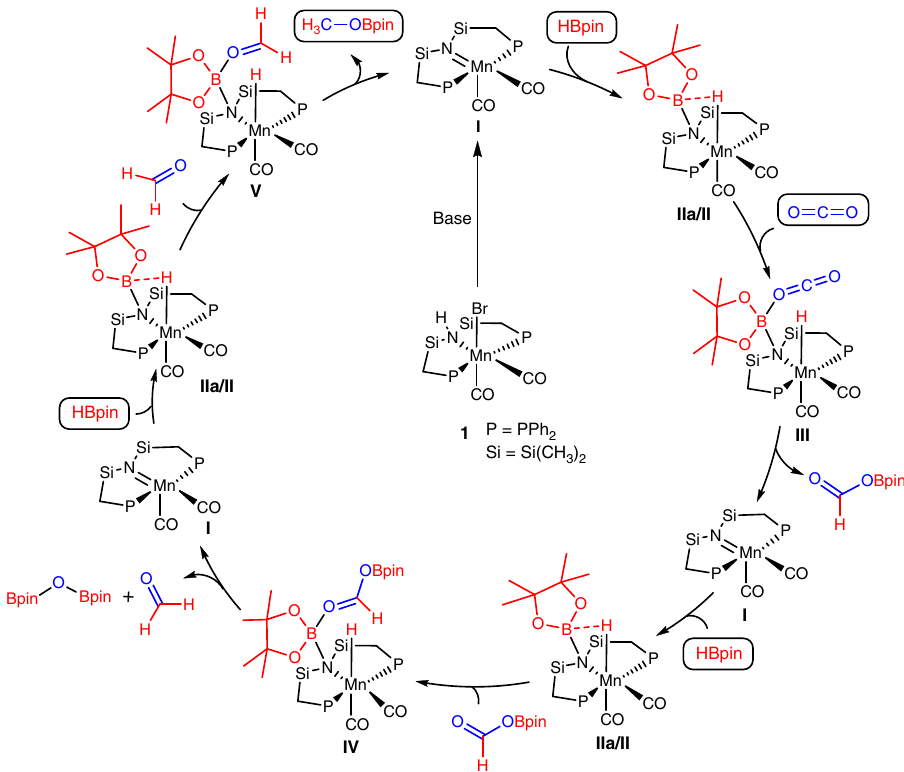
Fig. 3 Suggested reaction mechanism for the hydroboration of CO 2 catalyzed by complex